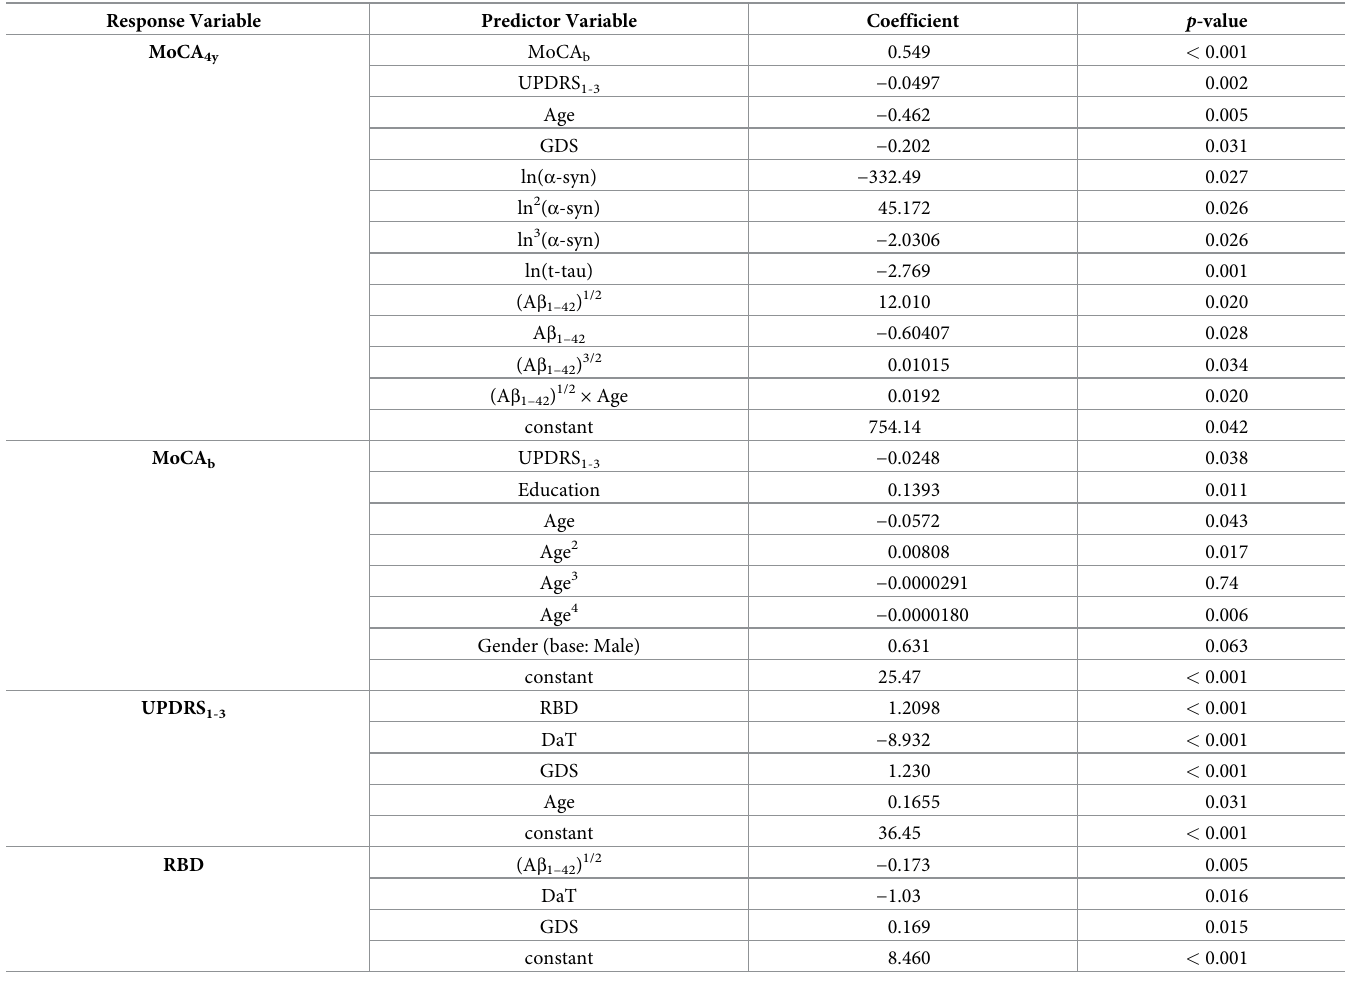
Table 1. Direct effects for the GSEM network in Fig 1A.